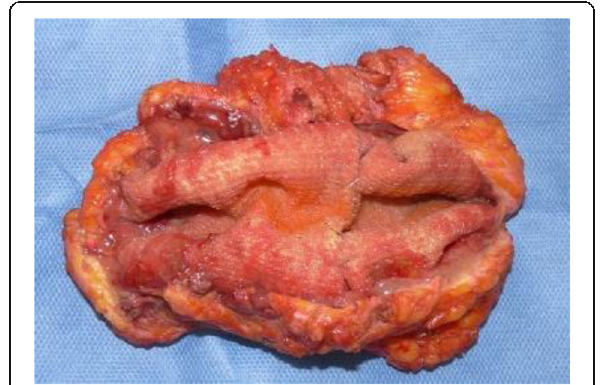
Fig. 6 Excised abscess containing everted mesh. MRSA was identified in the abscess